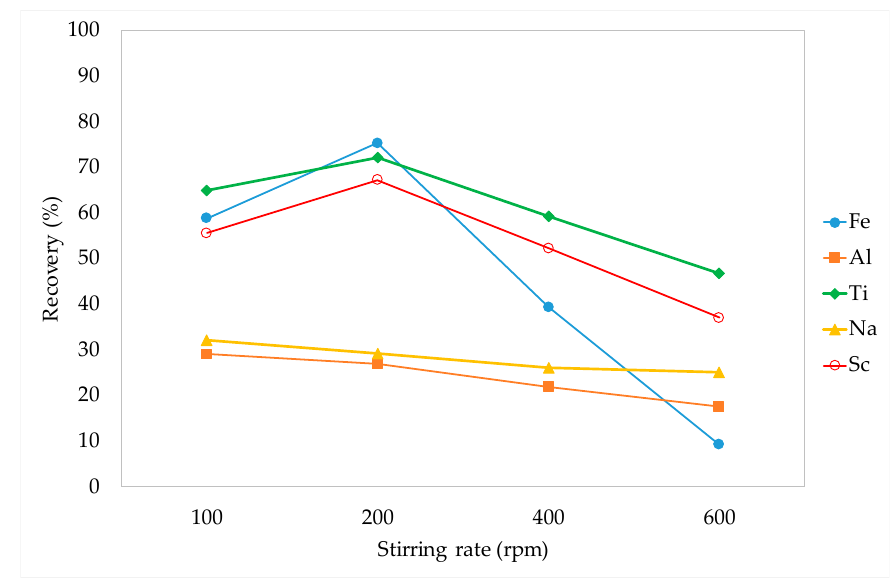
Figure 3. Investigation of the stirring rate effect on metals dissolution by leaching BR with